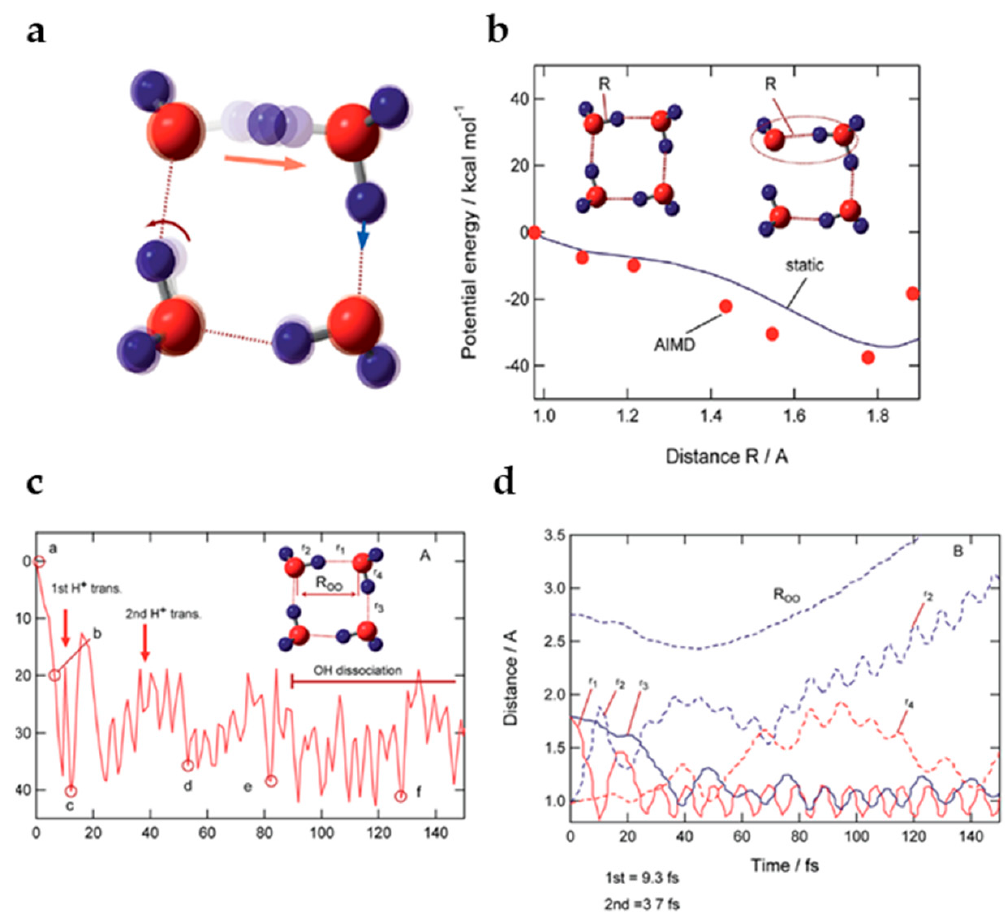
Figure 31. ( a ) Superposition of snapshots for the first proton transfer process. ( b ) Potential energy curve for the proton transfer process as derived from a static ab initio calculation (MP2 / 6-311 ++ G (d, p) level). The values obtained from the direct ab initio molecular dynamics (AIMD) calculation are given as filled circles. ( c ) Potential energy and ( d ) geometrical parameters of the water tetramer cation following the vertical ionization each as a function of time. Figure adapted from [118] with